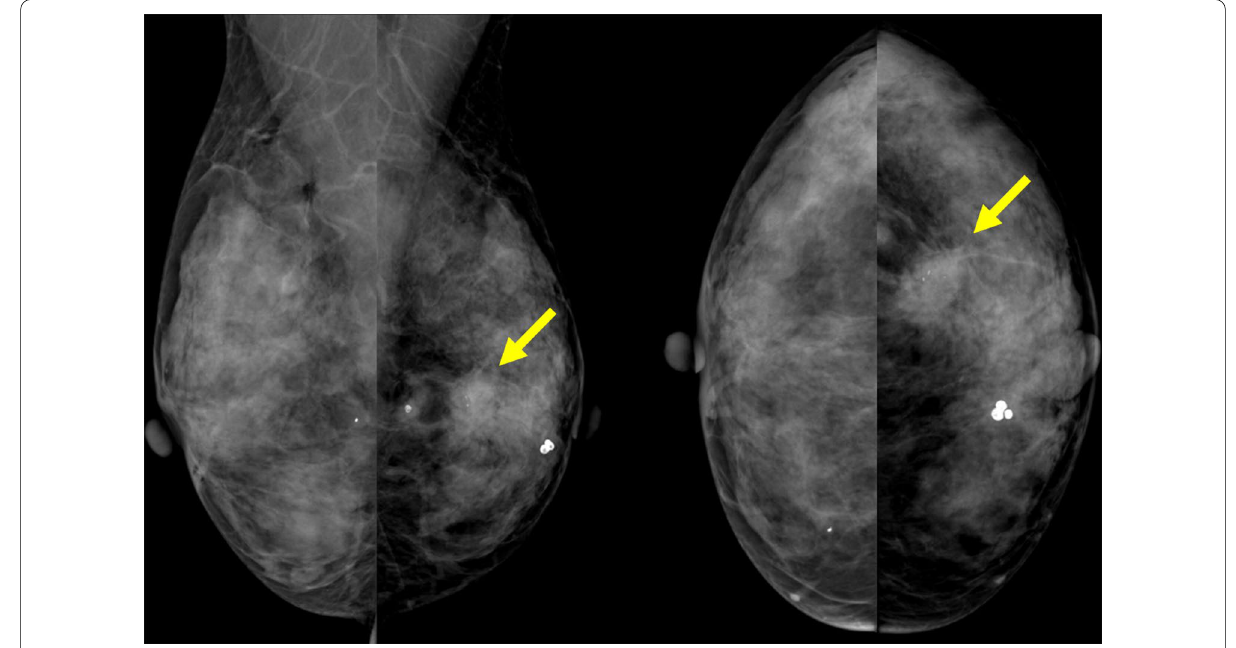
Fig. 1 Mammography. In the lower and outer areas of the left breast, a 2-cm micro-lobulated high-density mass was observed (arrows)